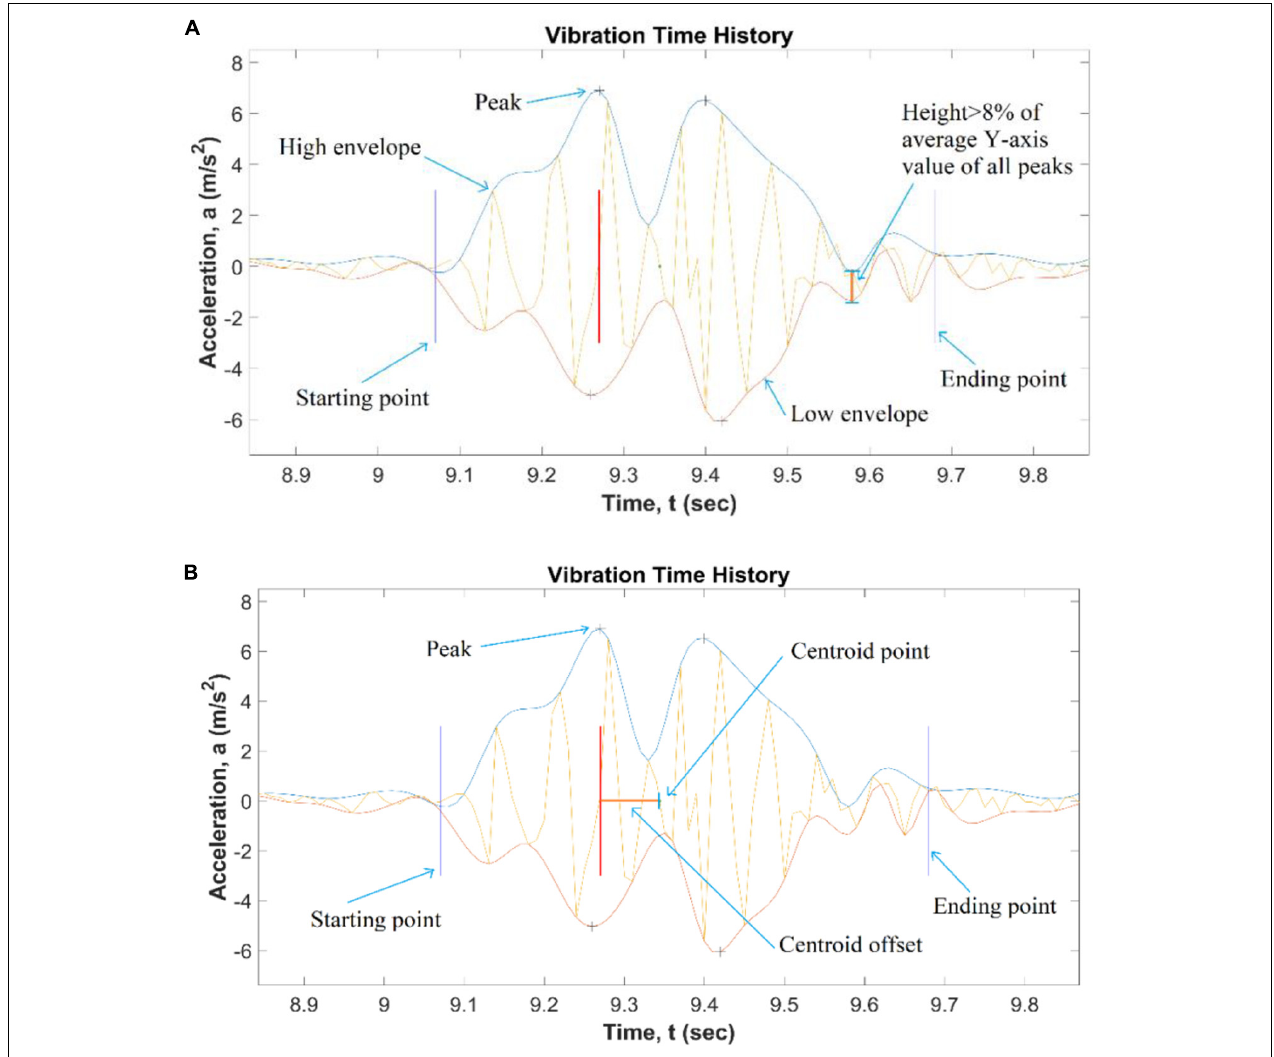
FIGURE 6 | Coordination Index determination for one dance step: (A) starting point and Ending point; (B) centroid